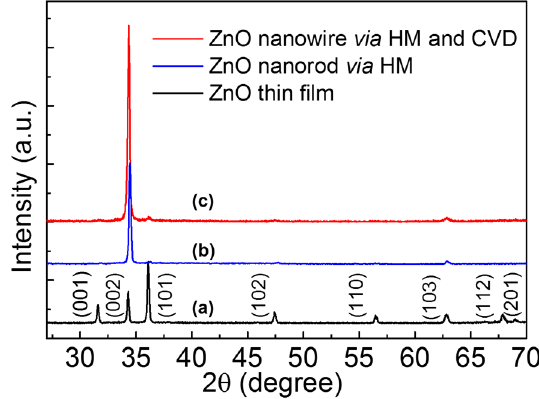
Figure 1. X-ray diffractometer (XRD) patterns of ZnO samples, ( a ) ZnO film on Si substrate; ( b ) and ( c ) are ZnO nanowire via hydrothermal method (HM) and self-catalytic chemical vapor deposition (CVD).